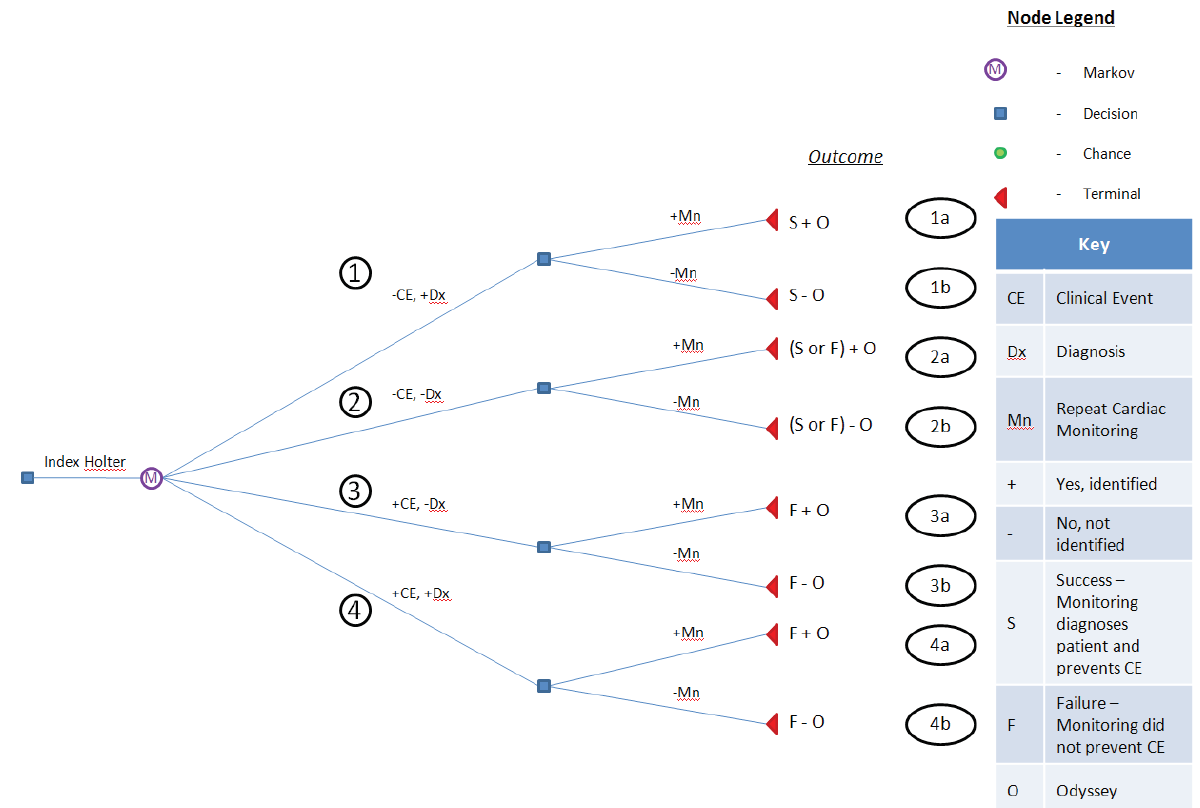
Figure 2. Outcomes Categories: Decision Tree – “Diagnostic